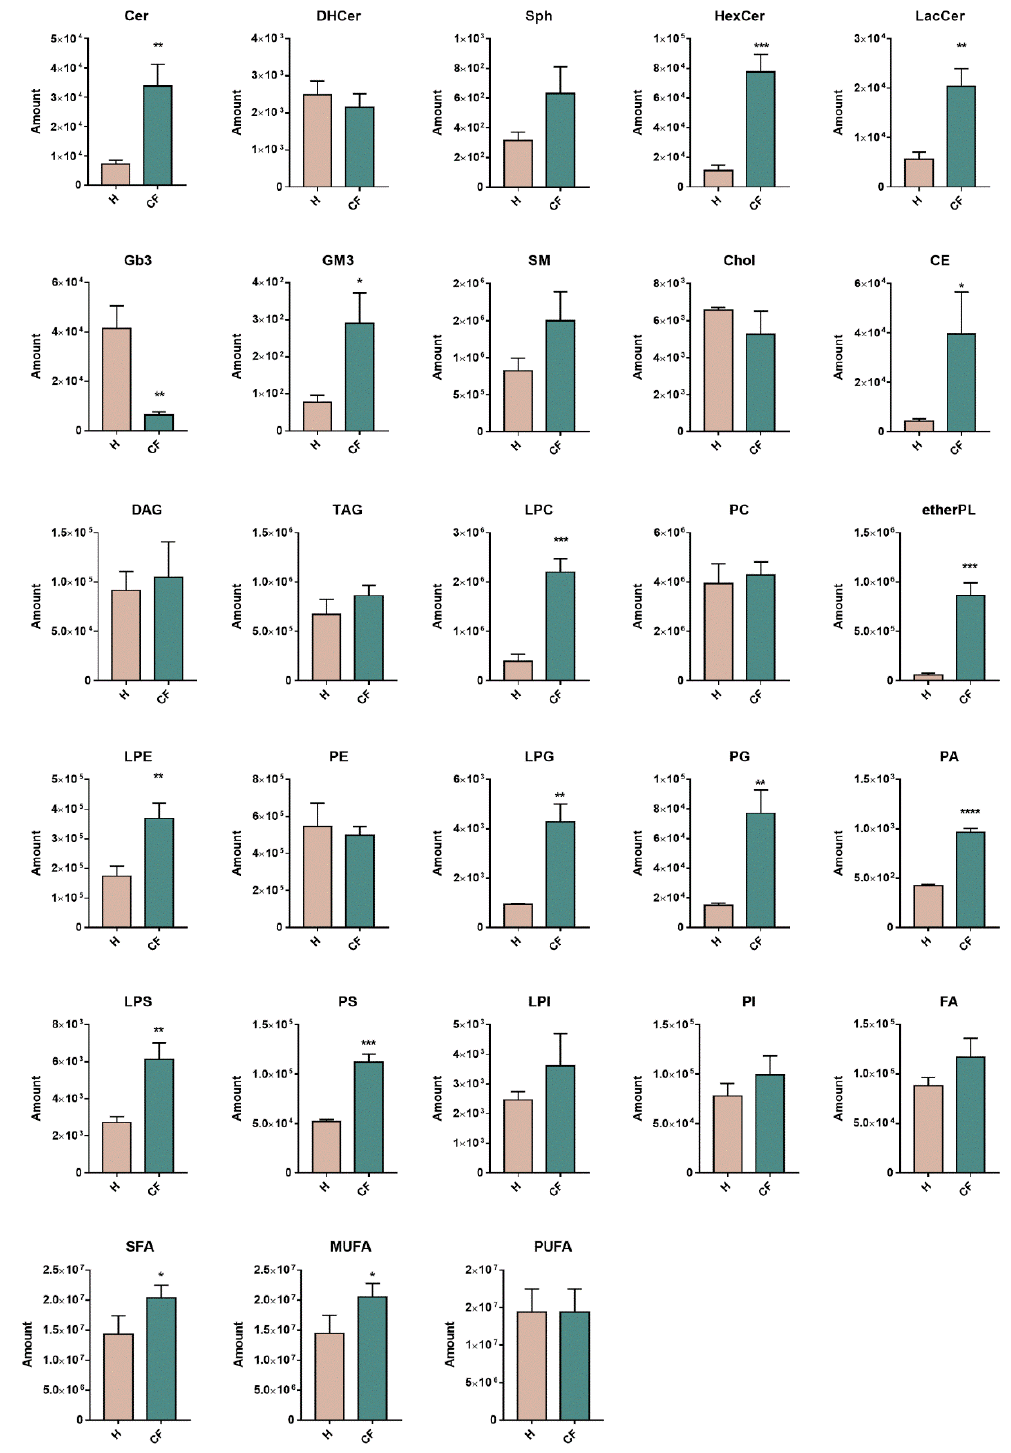
Figure 2. Lipid content comparison between healthy epithelial (H, n = 3 independent biological replicates) vs. cystic fibrosis (CF, n = 3 independent biological replicates) cells. Graphs represent the lipid amount (Amount, mean ± SD), which indicates the sum of the metabolites intensities within a class after normalization (see Equation (1)). Two-tailed unpaired t -tests were performed in each lipid class to establish a statistical difference (* p ≤ 0.05; ** p ≤ 0.01; *** p ≤ 0.001; **** p ≤ 0.0001).